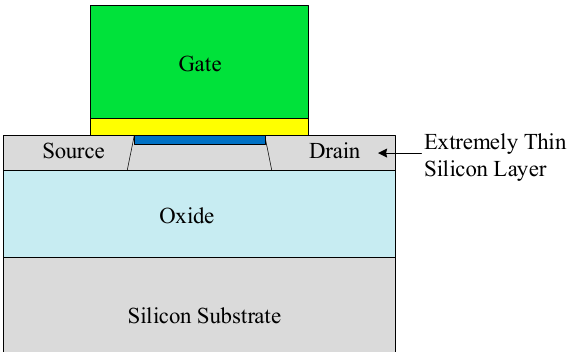
Figure 5. A buried insulator layer in a fully depleted SOI structure